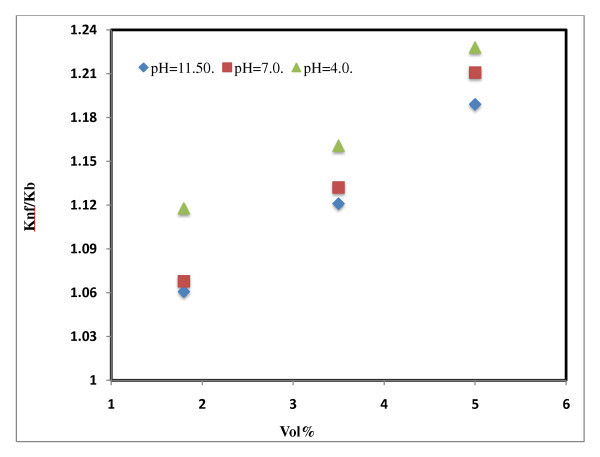
Effect of pH on thermal conductivity of water-based Al2O3 nanofluids. pH = 11.5 [16]; pH = 7.0 [16]; pH = 4.0 [16].